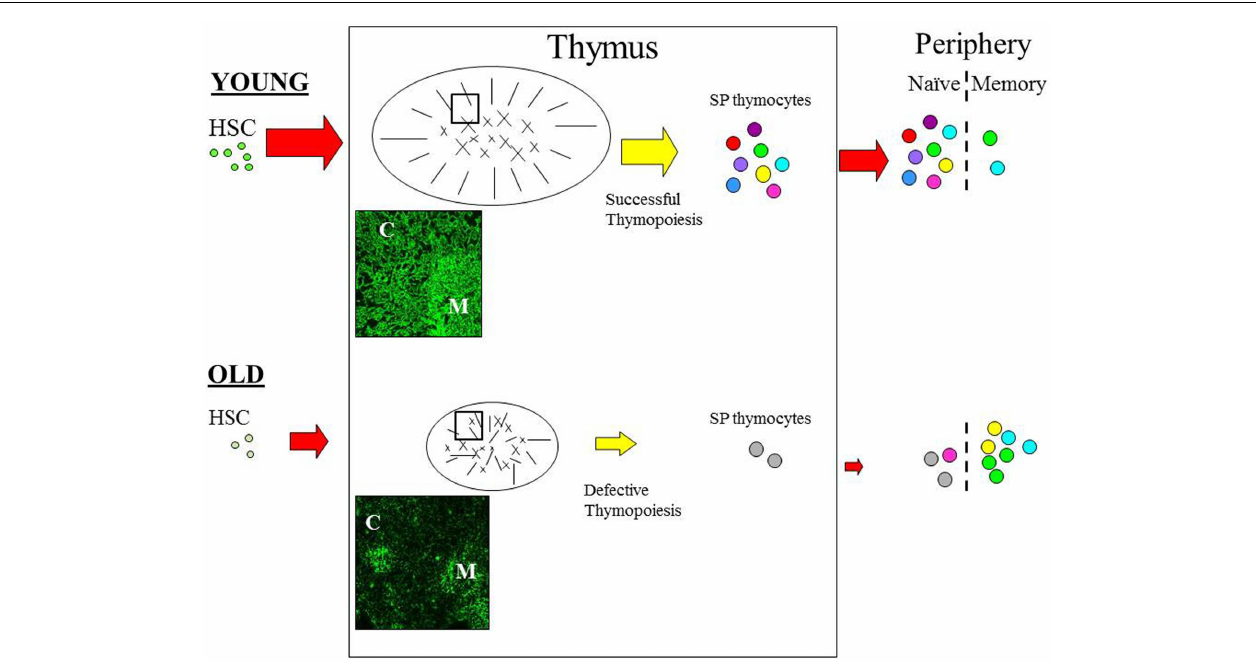
in the memory pool. Modifications in the thymic microenvironment are likely to have an impact on thymopoiesis resulting in defective RTE, which in turn disrupt thymic cross-talk leading to further alteration ofTEC structure. Immunofluorescence image of young (6weeks) and old (18months) murine thymus stained with anti-keratin antibody (55) which detects cortical (C) and medullary (M)TEC. In the young thymus, antibody staining shows the cortical epithelium as a network of long thin processes, while the medullary region reveals a squamous appearance. In contrast, the staining on old thymic section revealed a reduced network of cortical epithelial cells, the medullary region is smaller and more diffuse while the cortical-medullary junction is less distinctive; as also depicted in the schematic. C, cortex; M, medulla. Picture (100 ×